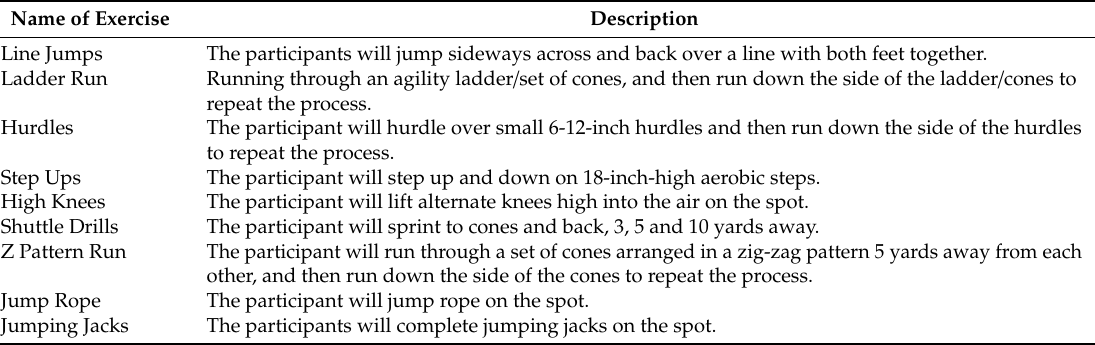
Table 1. Description of the employed aerobics circuit during the physical activity treatment